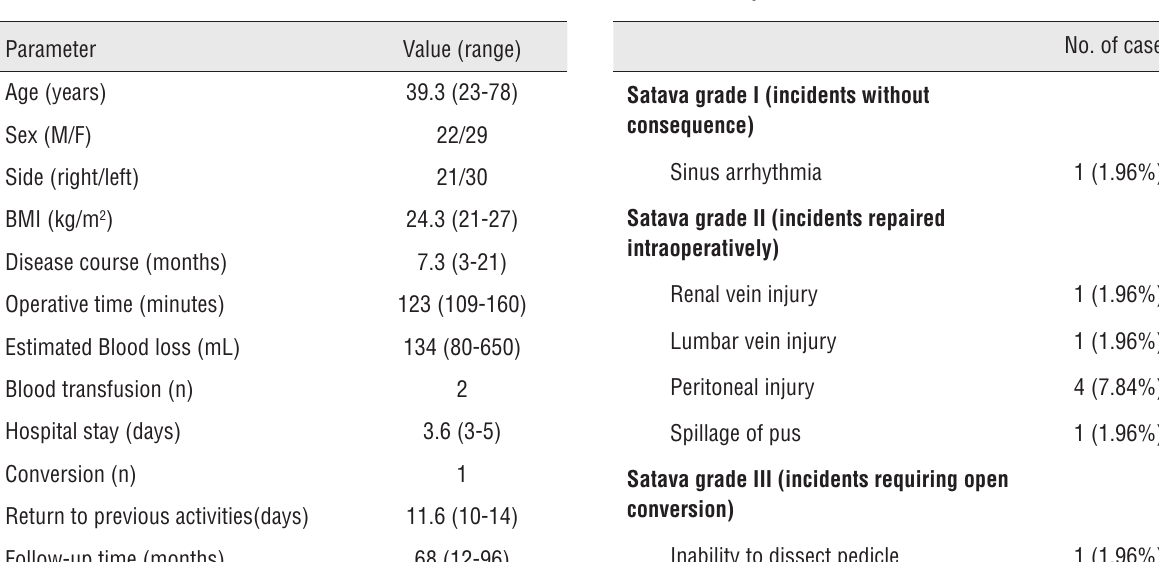
Table 2 - Peri-operative complication according to Satava classification system.